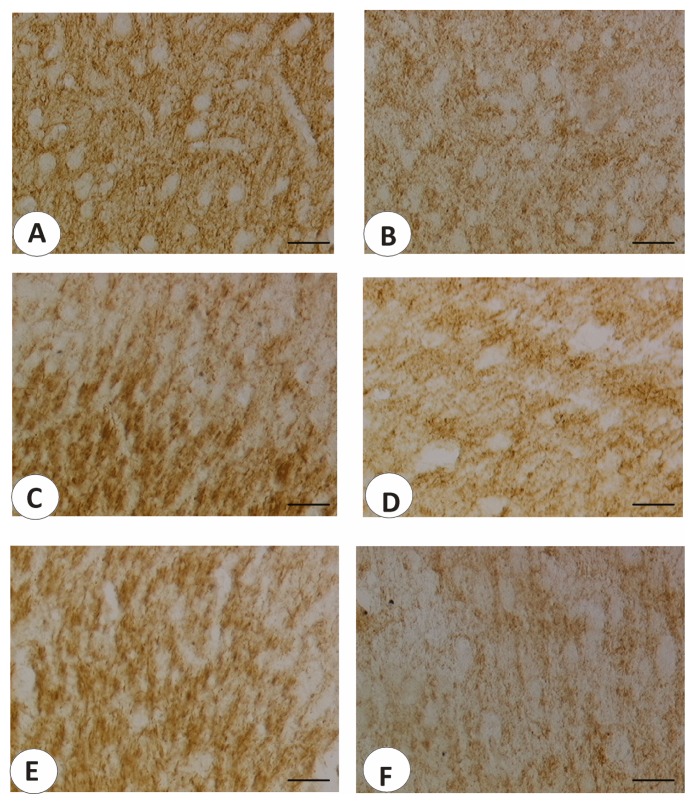
Sections of the frontal cortex (Zone 2) processed for the immunohistochemical demonstration of neurofilament phosporylated 200 kDa in control WKY rats (A), control SHRs (B), SHR treated with (+/−)-thioctic acid 125 μmol/kg/day (C), SHR treated with (+/−)-thioctic acid 250 μmol/kg/day (D), SHR treated with (+)-thioctic acid 125 μmol/kg/day (E), and SHR treated with (−)-thioctic acid 125 μmol/kg/day (F). Calibration bar: 25 μm.